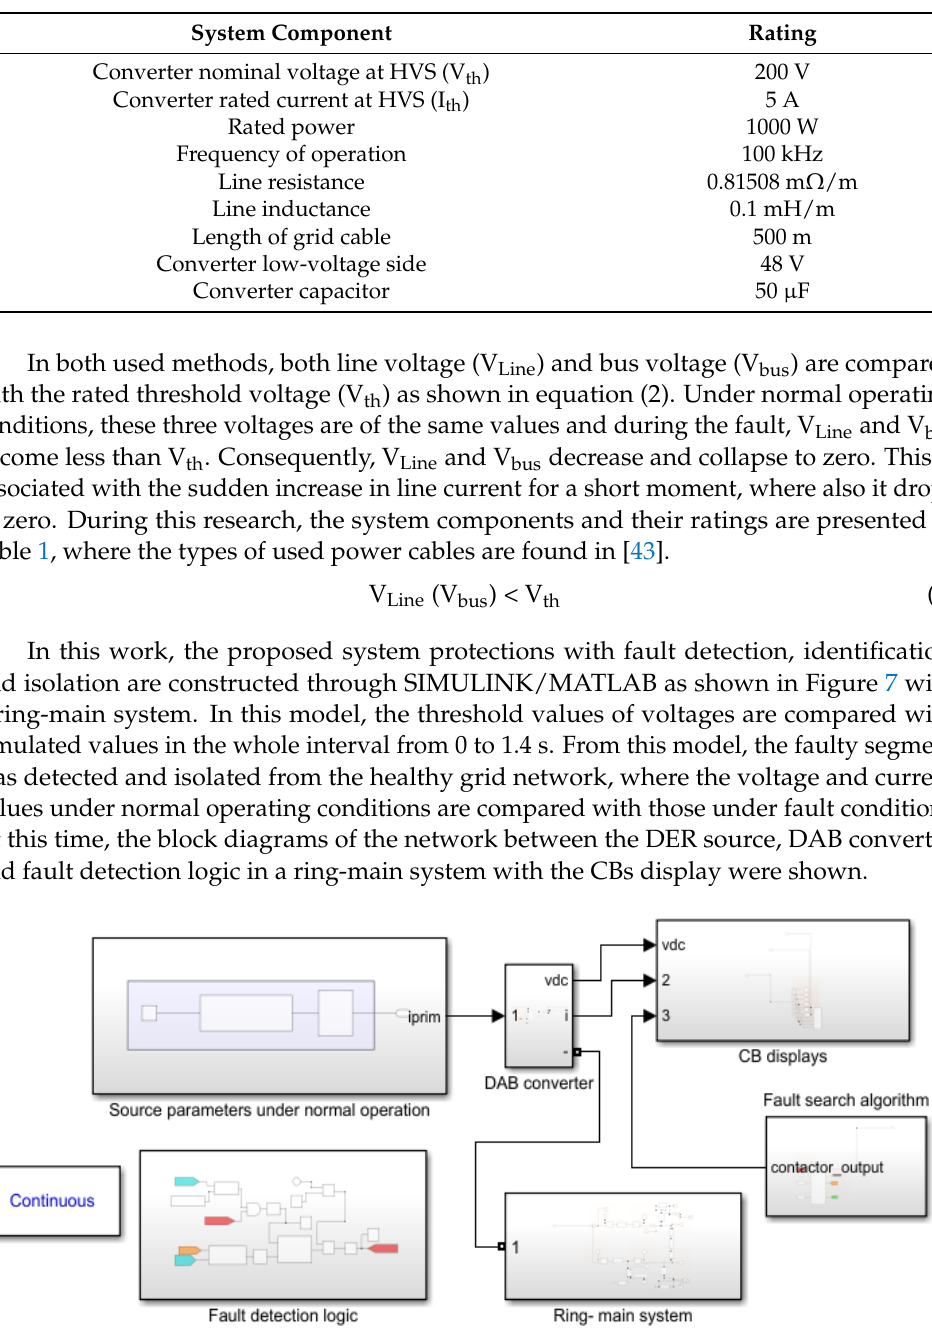
Table 1. Ratings of DCMG components for the study case.